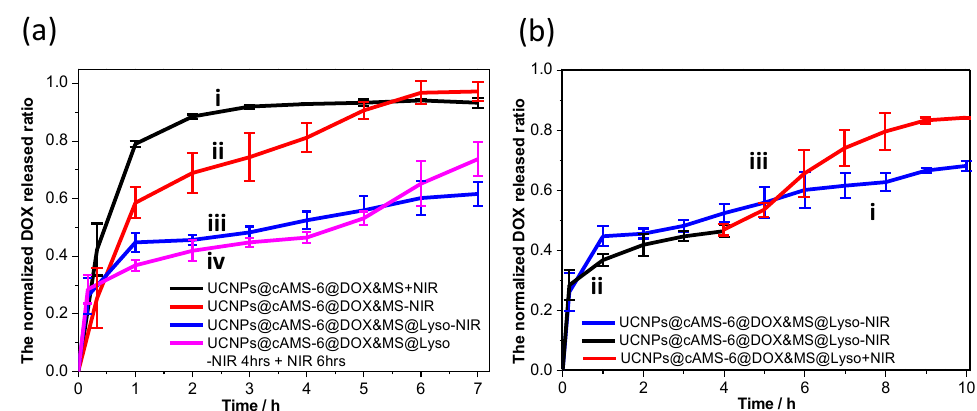
Figure 2. ( a ) Drug-release profile of DOX from UCNPs@cAMS-6@DOX&MS with (i) NIR light or (ii) without NIR light or from UCNPs@cAMS-6@DOX&MS@Lyso nanoparticles (iii) without NIR light or (iv) without NIR light for the first 4 h, following which the NIR light was switched on for the remaining 3 h; ( b ) drug-release profile of DOX from the UCNPs@cAMS-6@DOX&MS@Lyso nanoparticles over 10 h (i) without NIR light or (ii) without NIR light for the first 4 h, followed by (iii) NIR light exposure for the remaining 6 h.